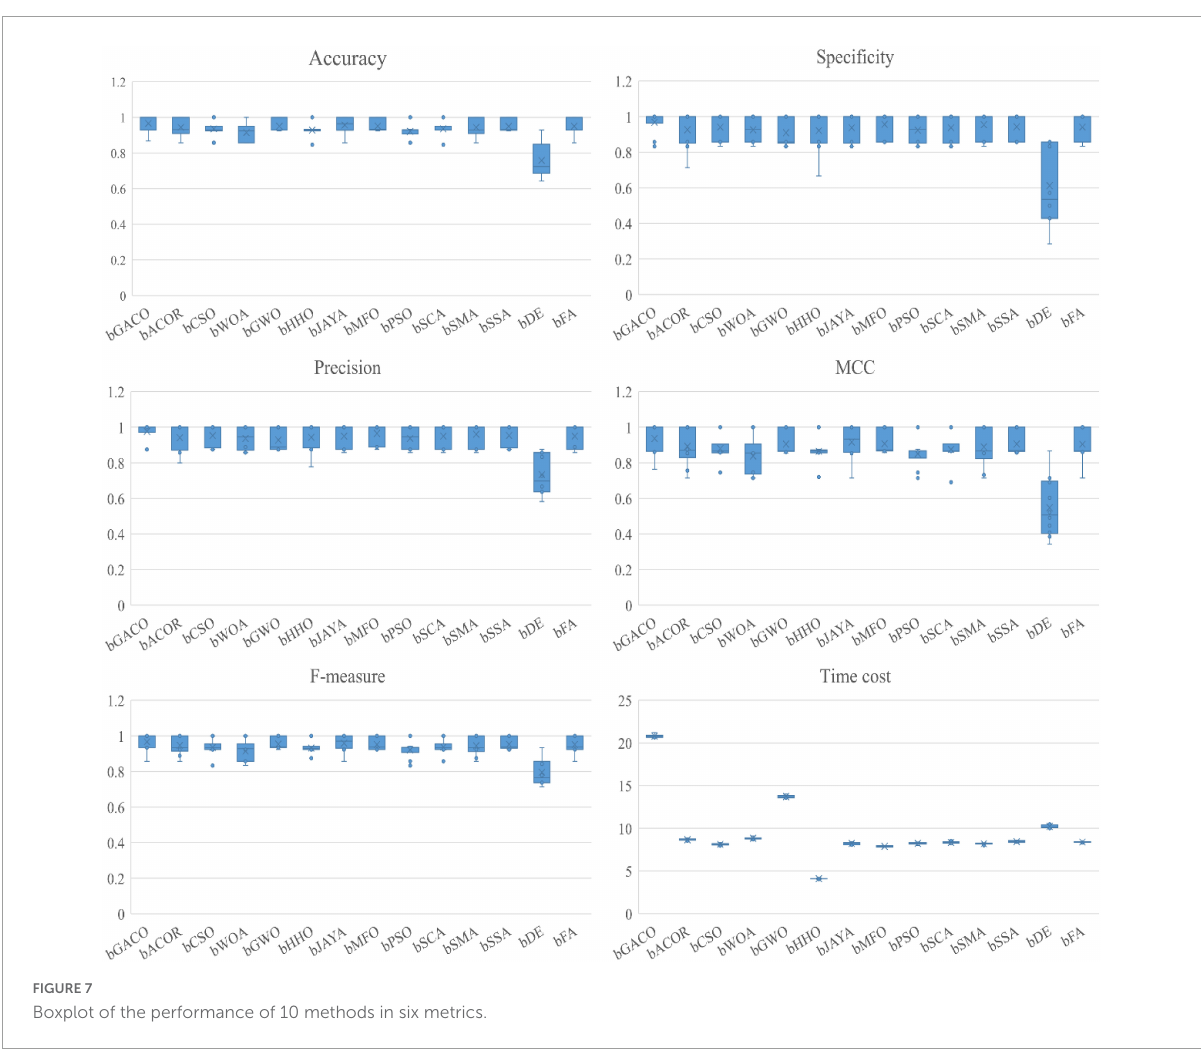
FIGURE7 Boxplot of the performance of 10 methods in six metrics.